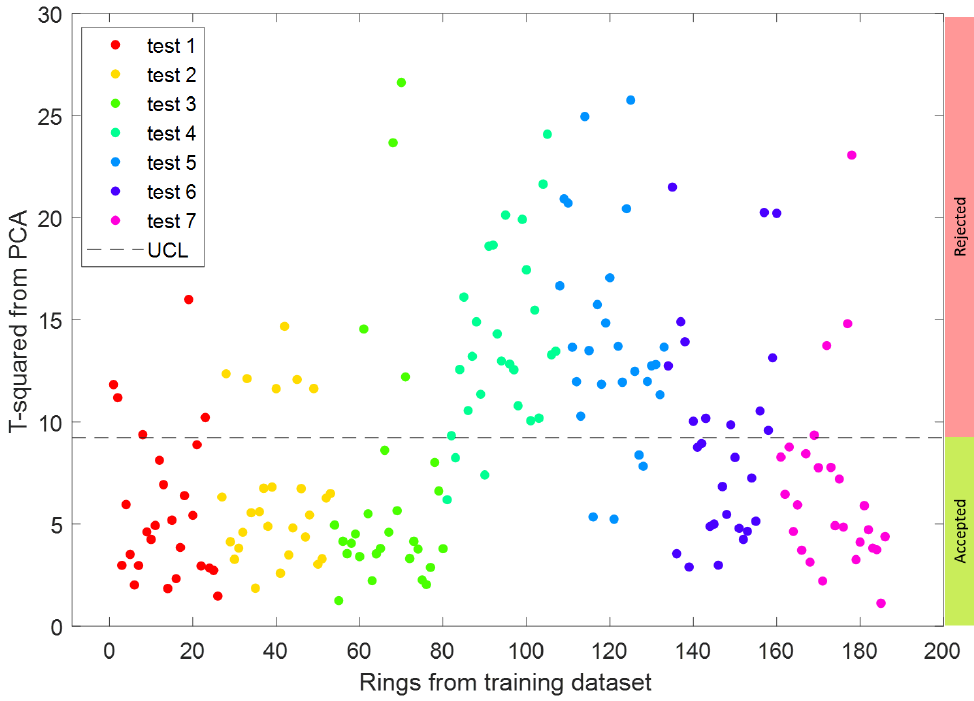
Figure 13. Calculated T 2 statistic from training quality dataset using MATLAB’s Principal Component Analysis (PCA) algorithm. The dashed line represents Upper Control Limit